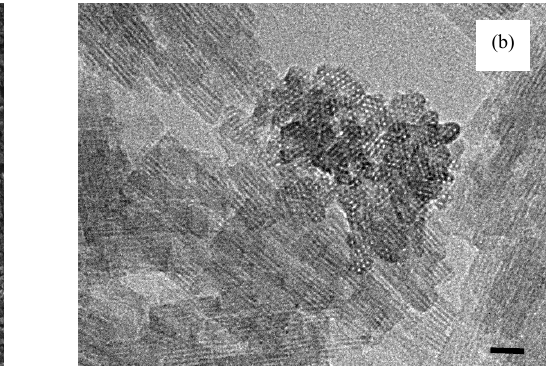
Figure 3. (Top row) normalized thickness, d , as a function of exposure time to 0 ( a ), 2 ( b ) and 4 ( c ) mM Cu 2+ solution; (bottom row) normalized refractive index, n , as a function of exposure time to 0 ( d ), 2 ( e ) and 4 ( f ) mM Cu 2+ solution. Black square symbol represents tetraethyl orthosilicate ( TEOS)-LTL data, and red spheroidal symbol represents TEOS-only data.